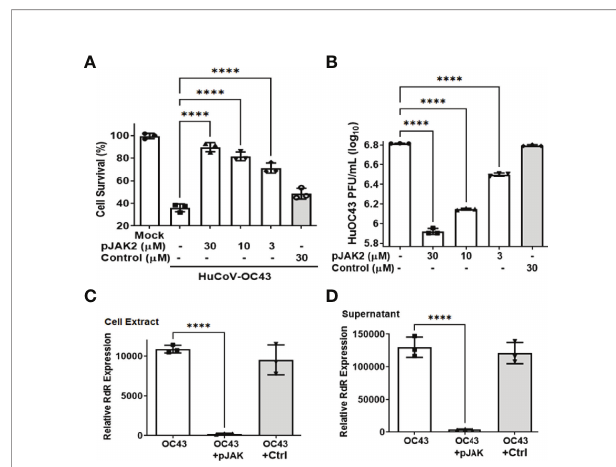
FIGURE 1 | (pJAK2 peptide exhibits antiviral activity against HuCoV-OC43 (A) . Protection of cell toxicity caused by HuCoV-OC43. RD cells (human rhabdomyosarcoma cells) were pre-treated with the indicated concentrations of pJAK2 or its control peptide for one hour followed by infection with HuCoV-OC43 at MOI of 0.1 for 1 hour. Cells were washed with PBS and incubated in low serum media for 72 hours. Cell viability was assessed using the CellTiter kit (Promega). p< 0.0001 between different concentrations of pJAK2 peptide and virus only. (B) . Antiviral activity of pJAK2 against HuCoV- OC43. RD cells were treated with pJAK2 or control peptide and infected as in (A) . At the end of 48 hrs, supernatants were harvested and used in triplicates for plaque assay using Vero E6 cells for 72 hrs. Cells were stained with crystal violet and plaques were counted. The results represent the average of 3 independent experiments. p<0.0001 between different concentrations of pJAK2 peptide and virus only. (C, D) . Inhibition of propagation as well as release of HuCoV-OC43 by pJAK2 peptide. RD cells were pre-treated with pJAK2 or its inactive control peptide (both at 30 µM) for one hour followed by infection with OC43 as in (A) for 48 hrs. RNA was extracted from cell extract (C) and supernatant (D) , converted to cDNA and used for qPCR with primers from RNA dependent RNA polymerase (RdR) encoded by OC43. Human b - actin primers were used to calculate relative expression of RdR.